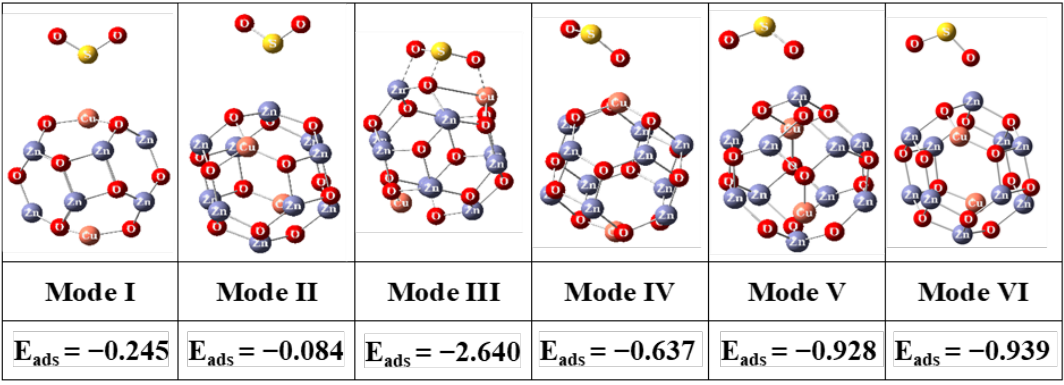
Figure 6. The optimized complexes with adsorption energies in eV of SO 2 /Cu 2 Zn 10 O 12 complexes. It is clear that the adsorption for SO 2 /Cu 2 Zn 10 O 12 and H 2 S/Cu 2 Zn 10 O 12 is chemisorp- tion for all the adsorption modes except for SO 2 /Cu 2 Zn 10 O 12 mode II and H 2 S/Cu 2 Zn 10 O 12 mode III. This indicates a strong interaction between the investigated gas and the cluster, which explains the sensitivity of the cluster to the considered gases. Assuming that the